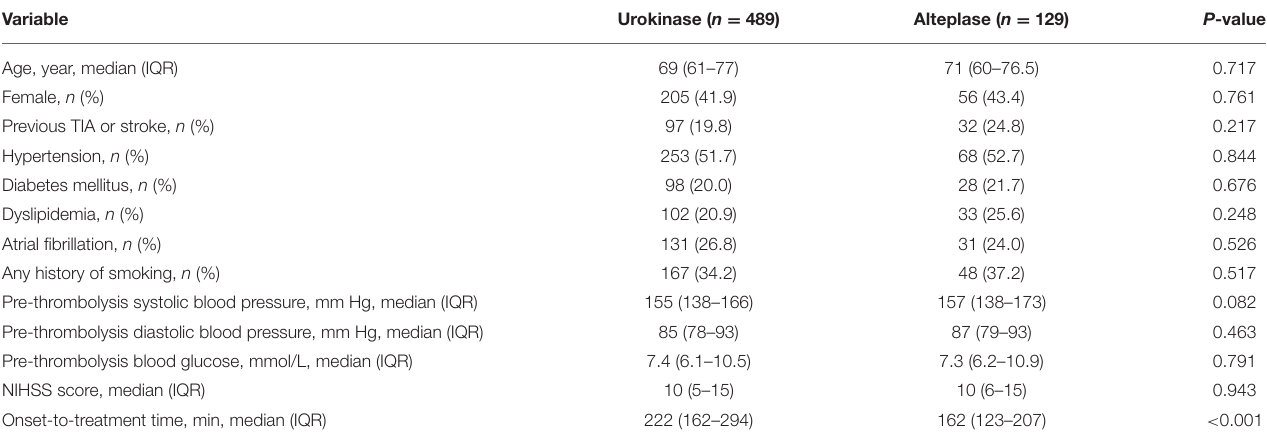
TABLE 1 | Baseline clinical characteristics of patients treated with urokinase or alteplase. Variable